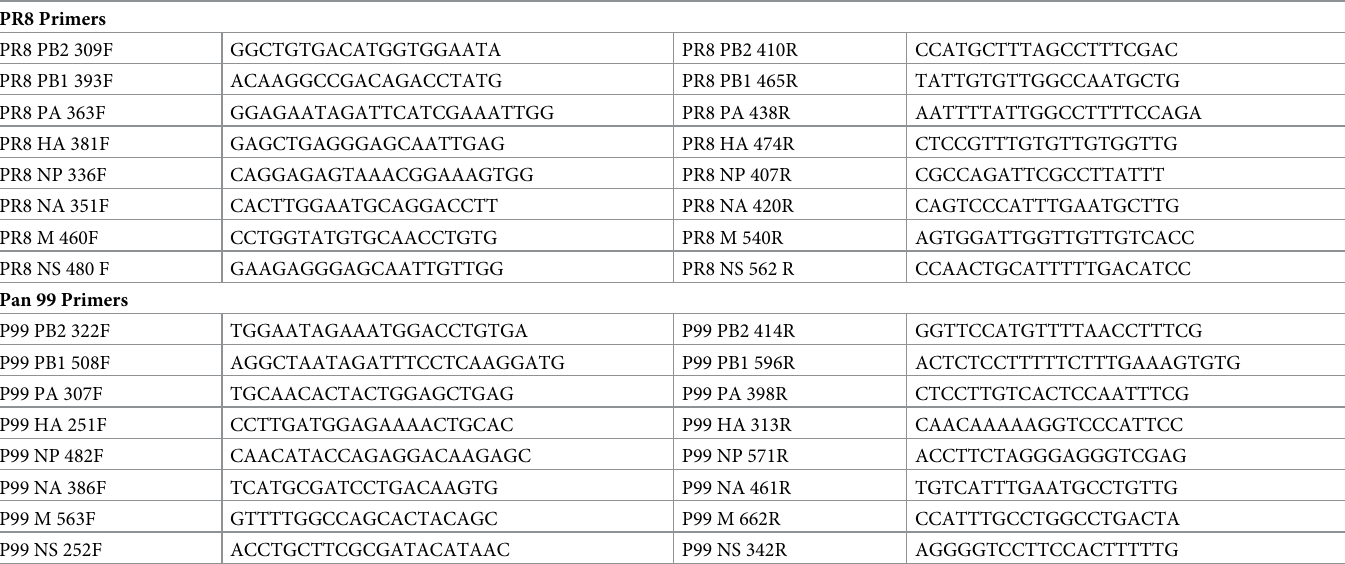
S1 Fig. Comparison of vRNP dynamics between WT PR8 and NP-Tc virus. (A-B) A549 cells were infected with WT PR8 or NP-Tc virus at MOI = 1 for the indicated time points and stained with FlAsH dye and an anti-RNP antibody. (C) Comparison of RNP puncta sizes between NP-Tc and WT PR8 viruses. (D) Comparison of number of RNP puncta in control A549 cells infected with NP-Tc and WT PR8 viruses. Scale bar = 10 μ m. Data are representa- tive of at least two independent experiments. S2 Fig. Large RNP puncta appear near Sec31a positive ER exit sites. Control A549 cells were infected with NP-Tc virus and at 16hpi, cells were stained with FlAsH dye and a Sec31a anti- body. RNP puncta with Sec31a in the periphery are indicated by arrows in the zoomed image. S3 Fig. Snap shots from live-cell imaging of NP-Tc virus infected cells. Selected frames from S1 Movie are shown with time (min:sec). Arrows indicate different events: RNP accumu- lation (green), puncta splitting (yellow) or coalescing (blue). S4 Fig. Loss of Rab11a affects post replication steps of the IAV life-cycle. (A-B) Rab11a KO cells show defects at a post replication step. (A) Control A549 and Rab11a KO cells were infected with H1N1-GFP (PR8; MOI = 3) and H5N1-GFP (VN04; MOI = 1) and GFP expres- sion was assessed at 16hpi by flow cytometry. (B) Control A549 and Rab11a KO cells were infected with H1N1 (PB2-Gluc; PR8) at MOI = 2 or 10 and incubated in media without